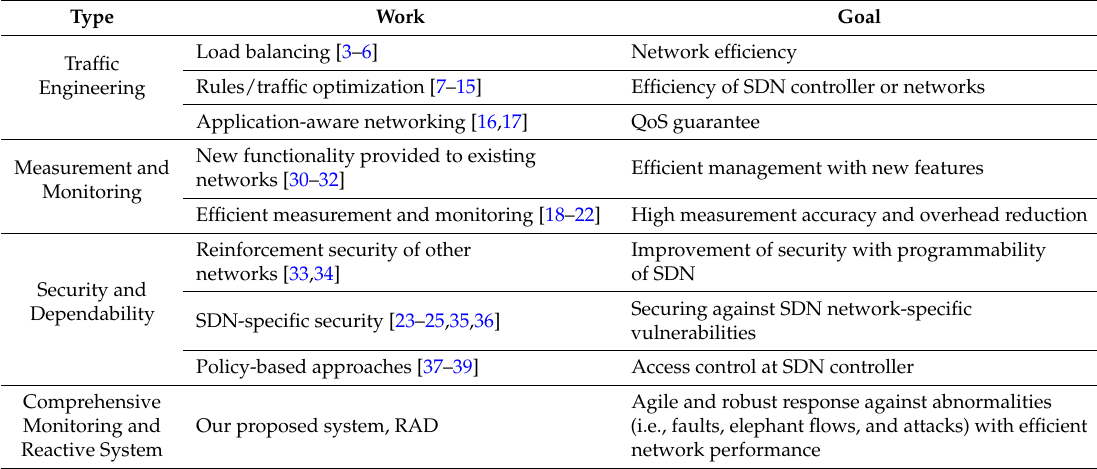
Table 1. Comparison of existing